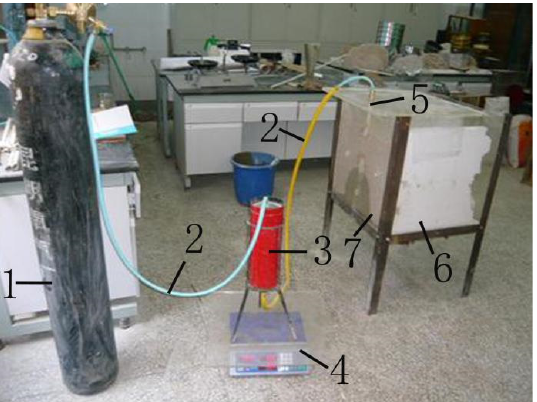
Figure 3. Grouting experimental device [30] (1—pressure supply equipment, 2—connecting pipe, 3— Table 1. Parameter values in the penetration grouting experiments [30].